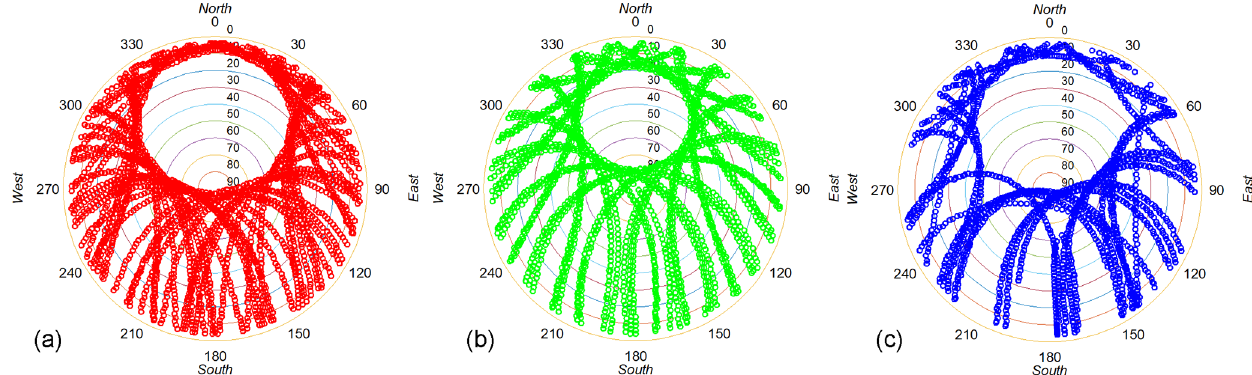
Figure 1. Observations of the sky acquired from ONS1 for 0 to 24h on 24 July 2019 for GPS (a) , Glonass (b) , and Galileo (c) .